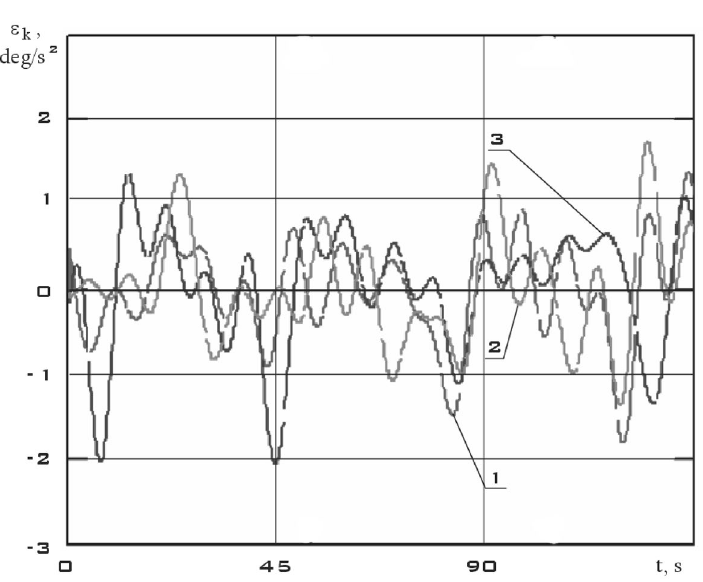
Figure 17. There are components of the angular acceleration vector in the CXYZ coordinate system 02/15/2014 from 12:00:06 to 12:02:21 (1 is ε x ; 2 is ε y ; 3 is ε z